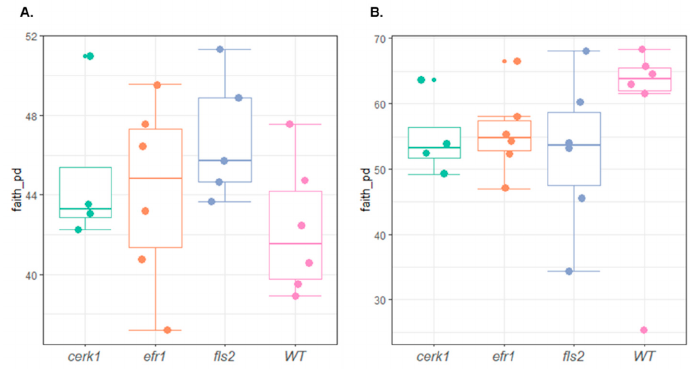
Figure 5. Histogram depicting α -diversity of the bacterial ( A ) and fungal ( B ) communities from rhizosphere of Arabidopsis PAMP mutants ( cerk1 , efr1 , and fls2 ) and the wild-type (WT; Col-0) grown in the Red River Farm soil (Table 1). Table 1. p- values of bacterial and fungal samples compared across different genotypes.